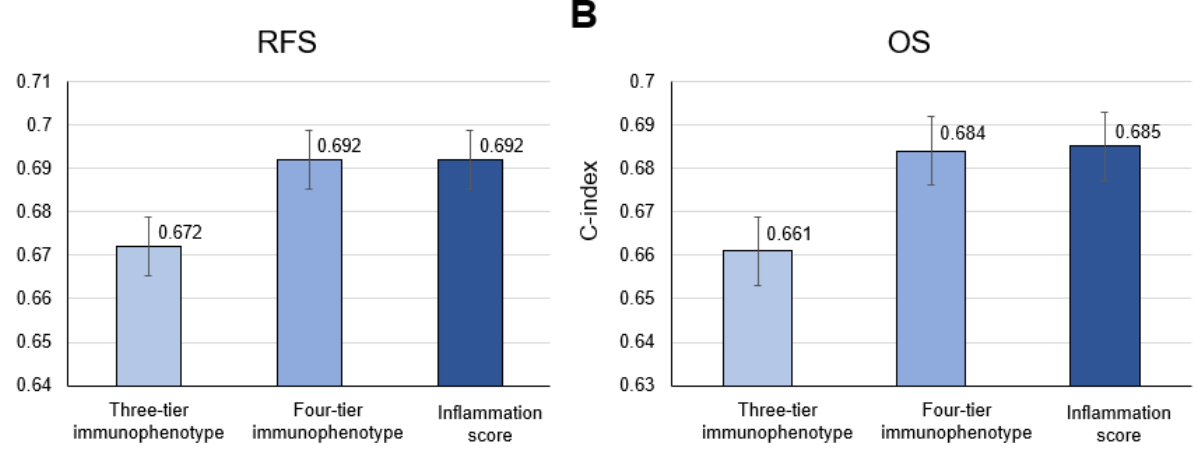
Figure 7. Comparison of accuracy among the three-tier and four-tier immunophenotype and inflammation score in ( A ) recurrence-free survival (RFS) and ( B ) overall survival (OS) in the principal cohort and the TCGA cohort, respectively.